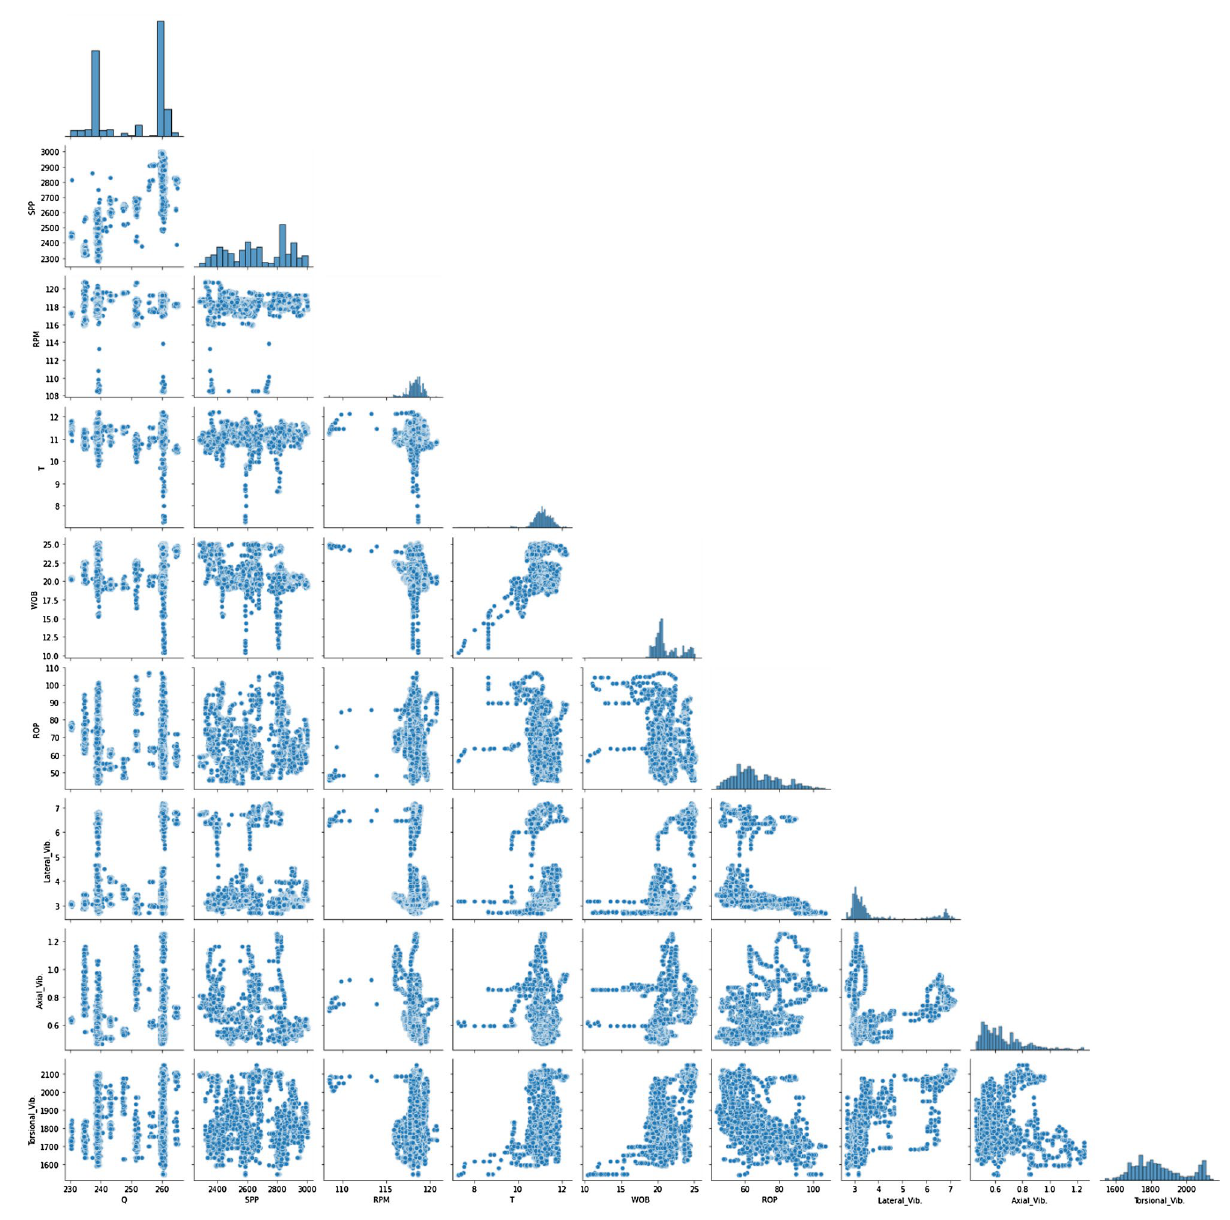
Figure 2. Pair plots for the data set features.